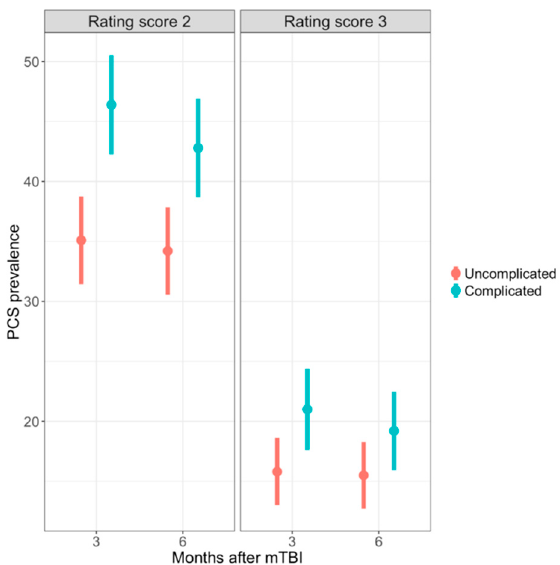
Figure 4. Prevalence of PCS for patients after uncomplicated and complicated mTBI at 3 and 6 months. PCS, post-concussion syndrome; mTBI, mild traumatic brain injury. Rating score of two = mild or worse; Rating score of three = moderate or worse.